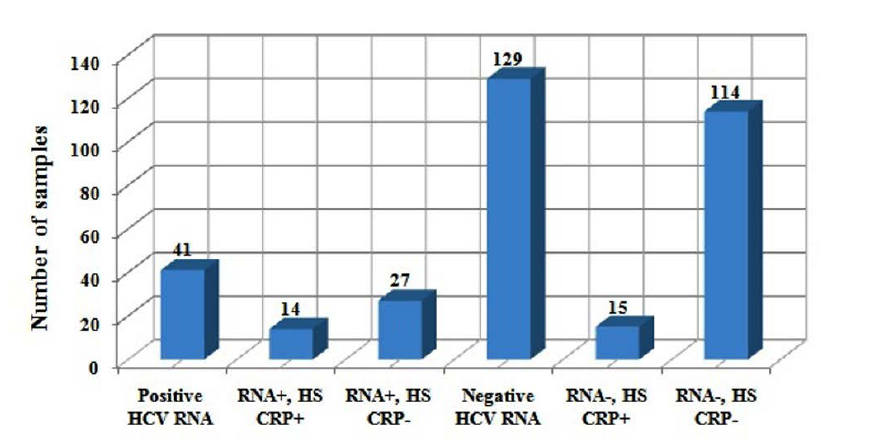
Fig. 1. Correlation between HCV RNA and hs-CRP